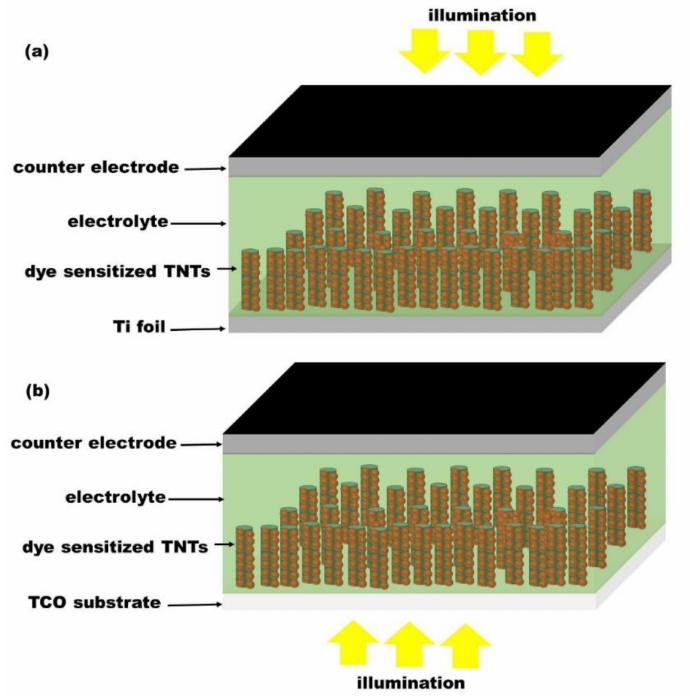
Figure 1. Schematic illustration of dye-sensitized solar cells under ( a ) back-side illumination and ( b ) front-side